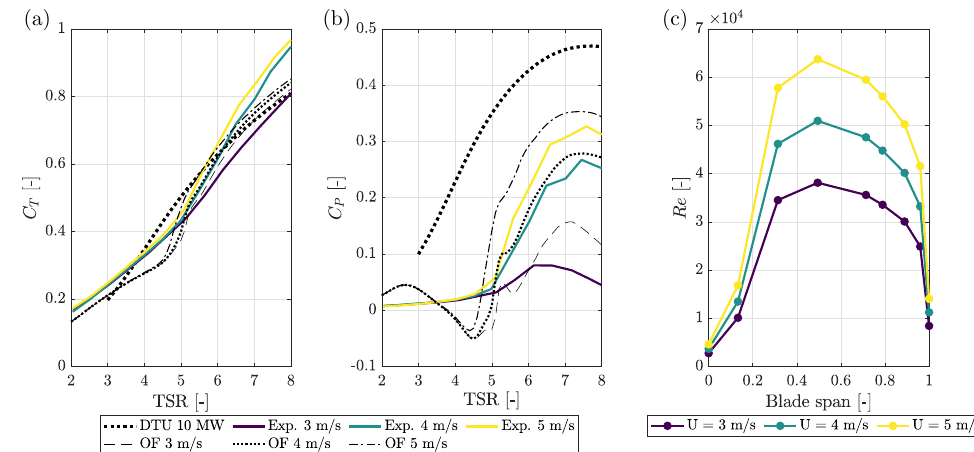
Figure 5. Performance coefficients of the wind turbine scale model for three wind speeds: wind tunnel measurements (Exp.) against OpenFAST (OF) model and DTU 10 MW. ( a ) Thrust coefficient. ( b ) Power coefficient. ( c ) Reynolds along the blade. Curves at one wind speed (11.4 m/s) are shown for the DTU 10 MW because Reynolds- dependent aerodynamics is not considered in the OpenFAST model of the reference